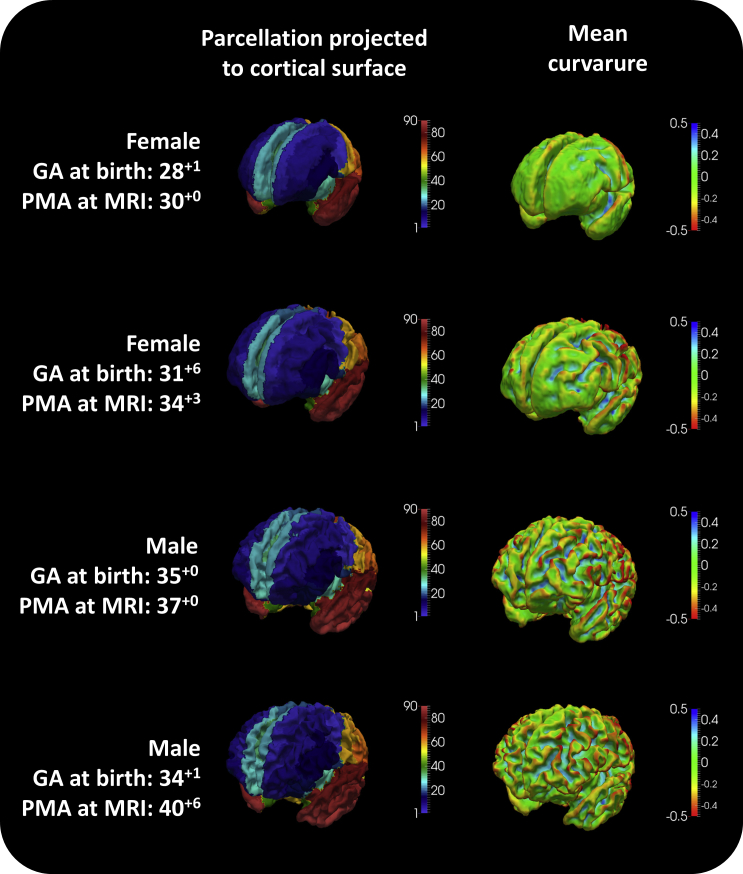
Cortical Surface reconstruction and its overlay with crotical segmentation (AAL atlas) and estimated mean curvature at each vertex in four representative subjects.